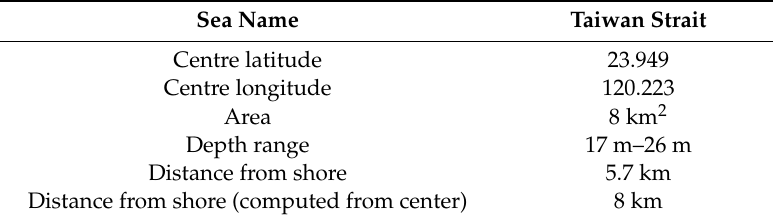
Figure 2. Locations of the Changhua ‐ South Offshore Wind Farm of Taiwan, meteorological mast, floating LiDAR device, MERRA location 1 and 2, and onshore Central Weather Bureau (CWB) station at Fangyuen, Puyen and Lukang. Table 1. Location and environment of Changhua ‐ South Offshore Wind Farm [21].